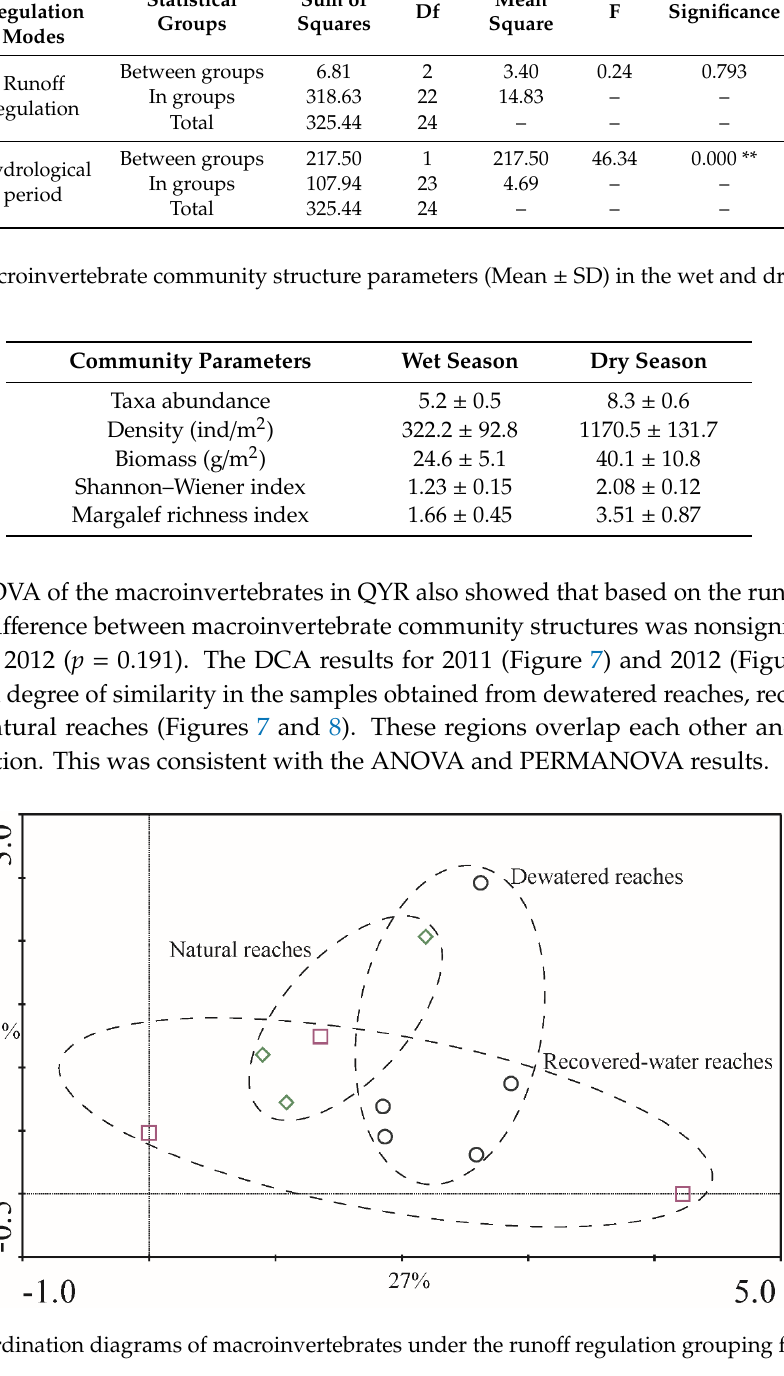
Table 6. One-way ANOVA results for macroinvertebrate abundance under two flow regulation modes in Qingyang River (QYR).